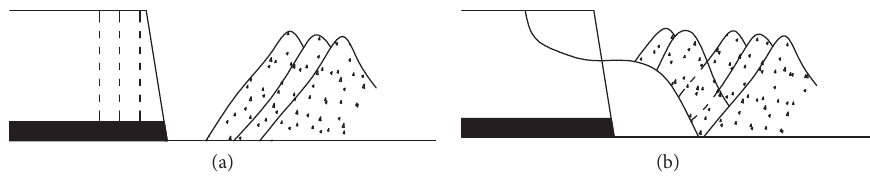
Figure 1: Overburden stripping by the blast-casting method in an opencast coal mine. (a) Inner-dump. (b) Blast-casting